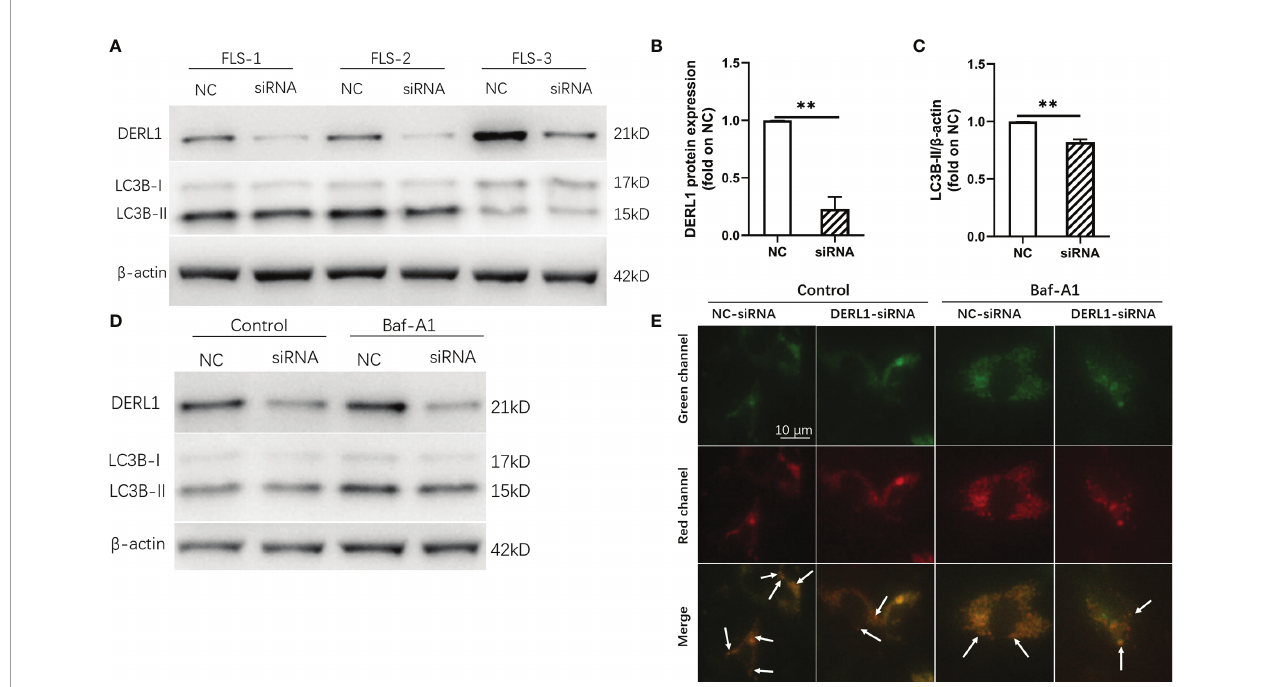
FIGURE 8 | Experimental validation of the relationship between DERL1 and autophagy. (A) RA-FLS were transfected with NC-siRNA (80nM) and DERL1-siRNA (80nM) for 48h, the level of DERL1 and LC3B were detected by western blotting. (B, C) Relative densitometric analyses of DERL1 and LC3B in (A) . (D) Autophagic fl ux was monitored in RA-FLSs after 48 hours of transfection with DERL1-siRNA or NC-siRNA in the presence or absence of 0.1 m M ba fi lomycin A1 (Baf-A1). (E) RA- FLSs infected with mCherry-GFP-LC3B adenovirus were transfected with DERL1-siRNA or NC-siRNA for 48 hours in the presence or absence of 0.1 m M Baf-A1, and the autophagic fl ux was assessed under fl uorescence microscope. Student ’ s-t test with Welch ’ s correction was used for the data analyses in (B, C) . ** P <